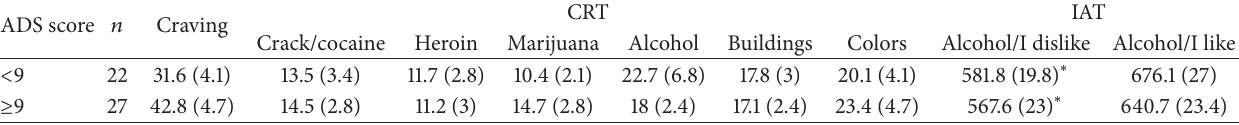
Table 1: Groups, sample size, craving score, and performance on the CRT and IAT in subjects tested in the Alcohol study .